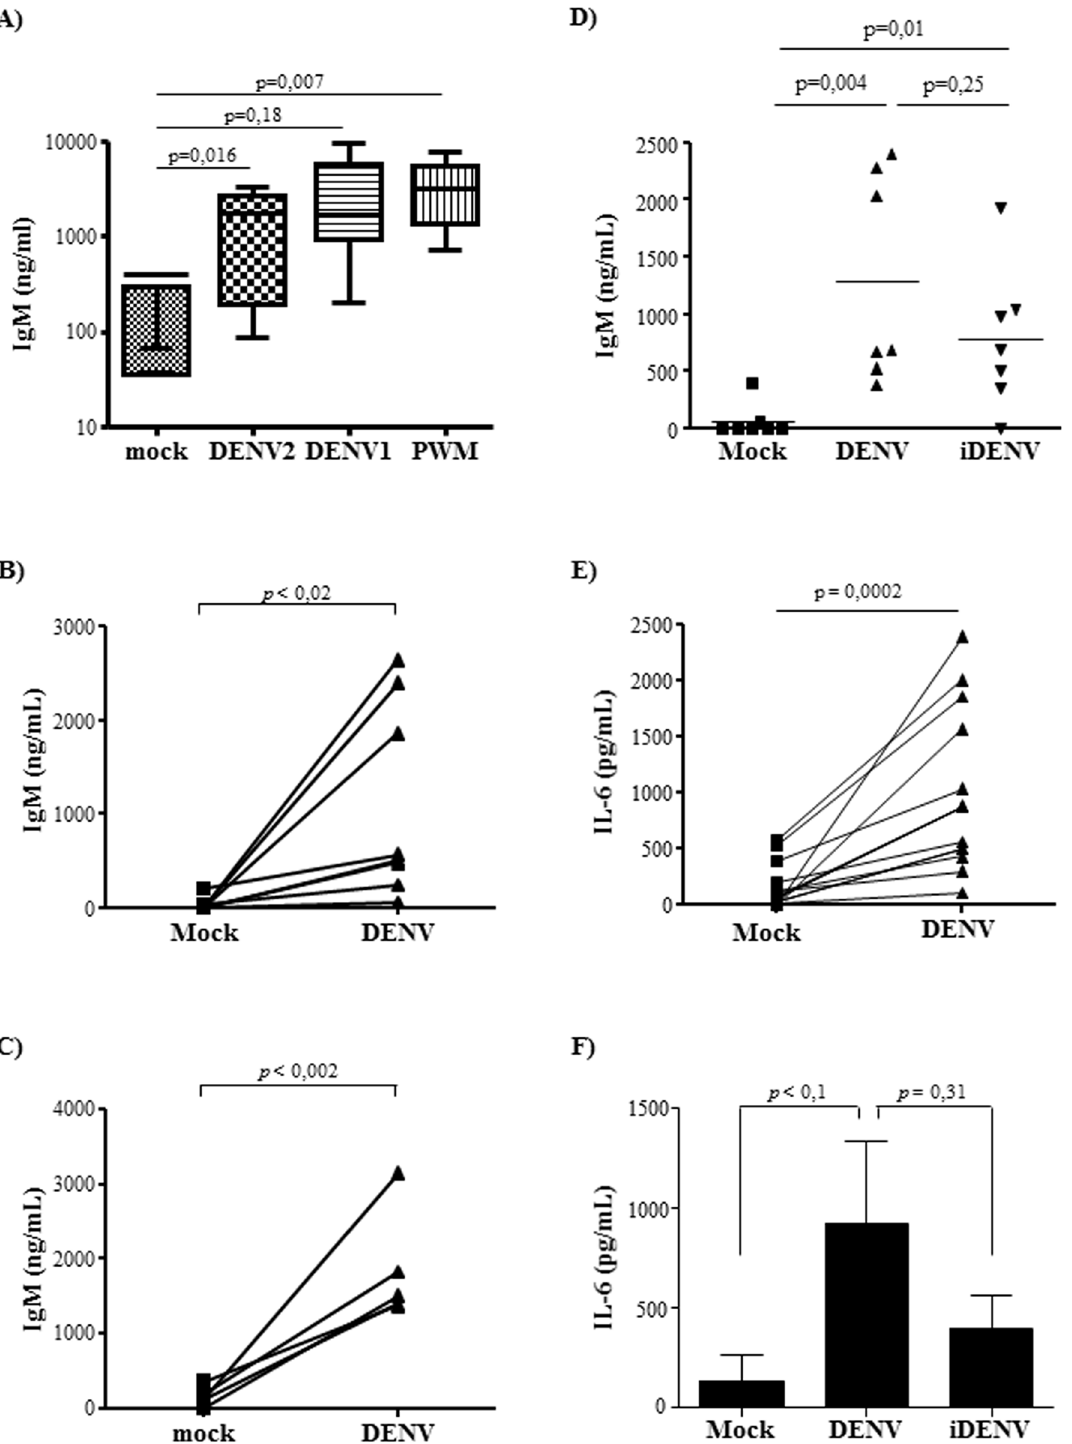
Fig 2. DENV induces polyclonal B cell activation. A) PBMCs isolated from healthy donors were mock-treated or cultured with DENV2 or DENV1, at an MOI of 1. PWM was added in the cultures as a positive control. After 12 days, the supernatants were harvested and total IgM levels were measured by ELISA. The graph indicates the median and standard deviation of 6 individual donors B-C) Purified B lymphocytes obtained from DENV seropositive (B) or seronegative (C) donors were mock-treated or cultured with DENV2 at a MOI of 1. After 12 days p.i., the supernatants were harvested and IgM levels were measured by ELISA. The lines indicate the IgM response to mock-treatment or DENV infection obtained from the same donor. D) The cells were mock-